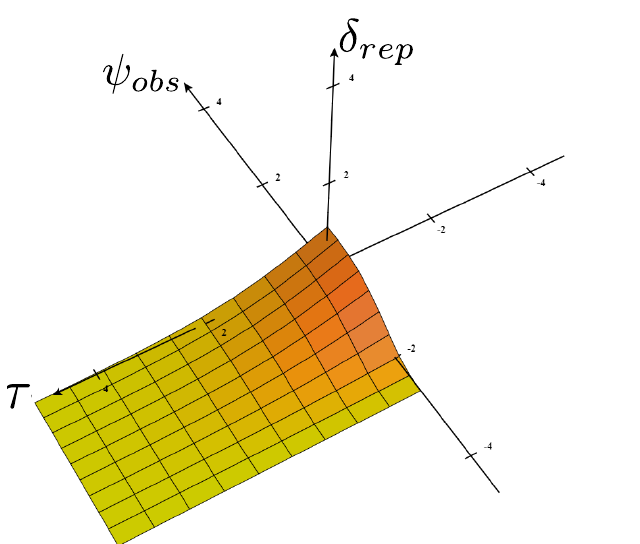
Figure 2. Characteristic plot of δ rep for negative values of ψ obs